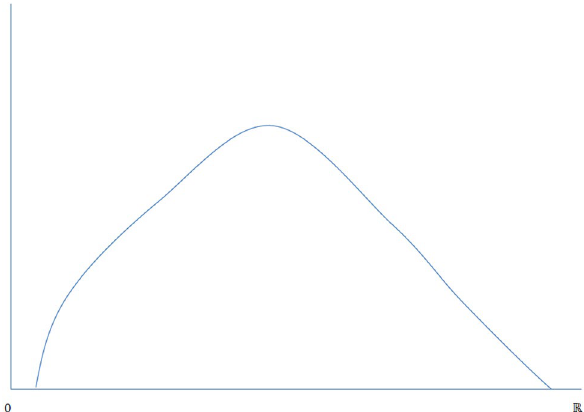
Fig. 3 Nonlinear fuzzy number